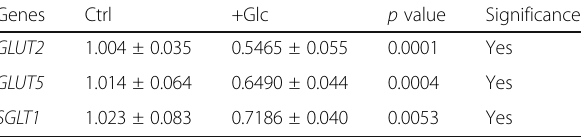
Table 3 mRNA expression levels of glucose-regulated genes